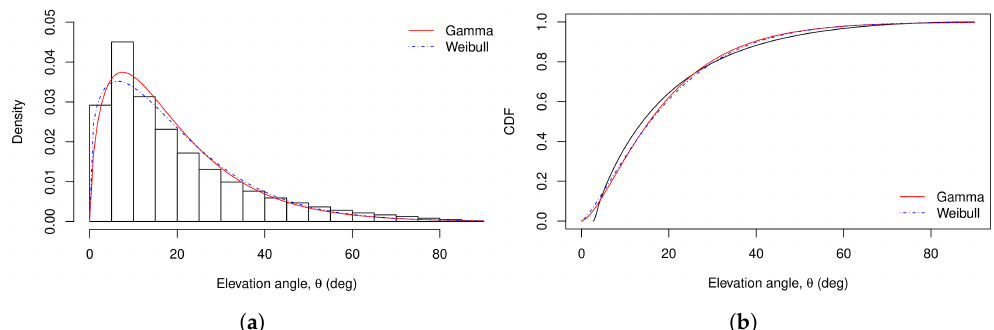
Figure 7. ( a ) Histogram and ( b ) theoretical densities for one of the elevation angle data sets obtained from the performed